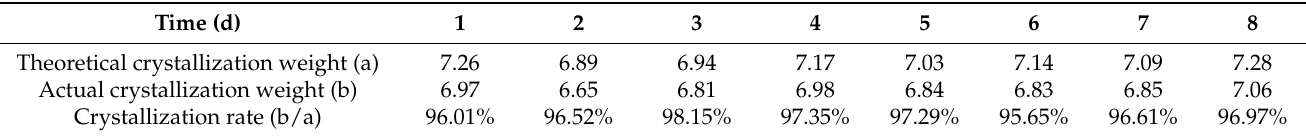
Figure 6. Concentrated water crystals after drying of the salt. Table 4. Crystal precipitation effect.